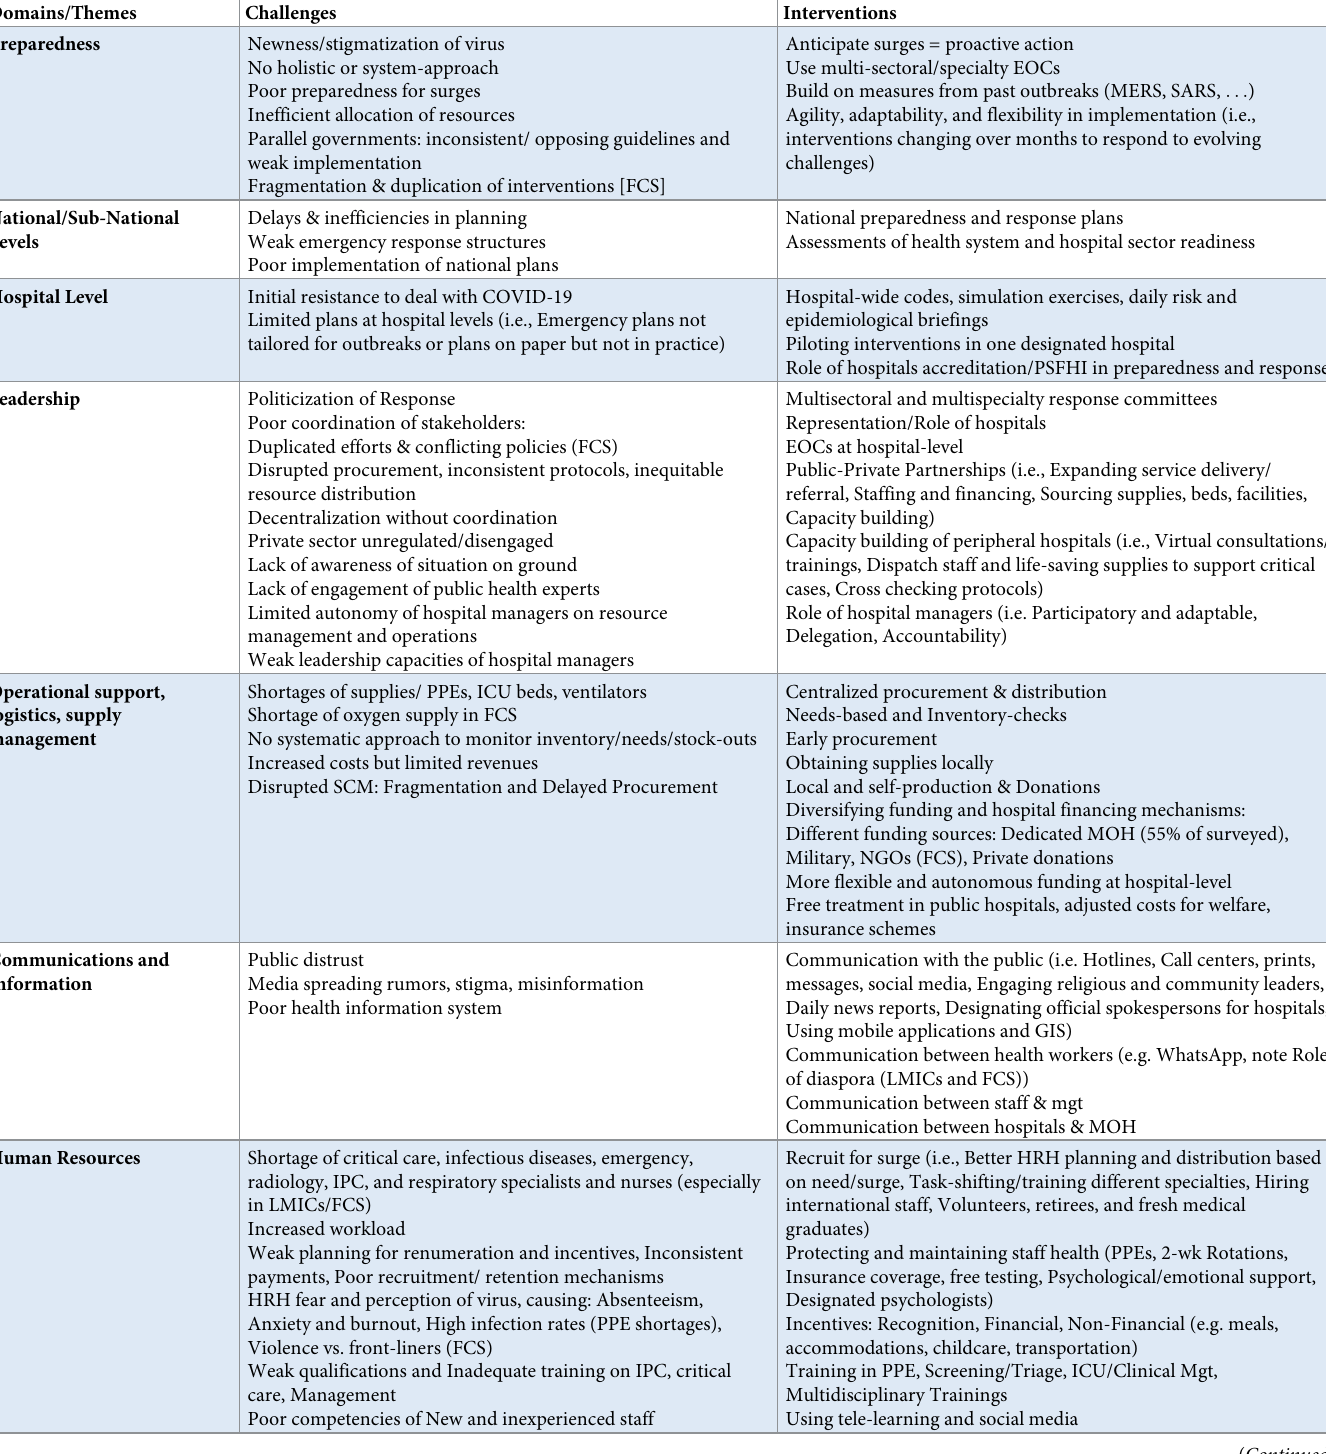
Table 1. Summary of main themes for EMR hospitals’ challenges and interventions by checklist